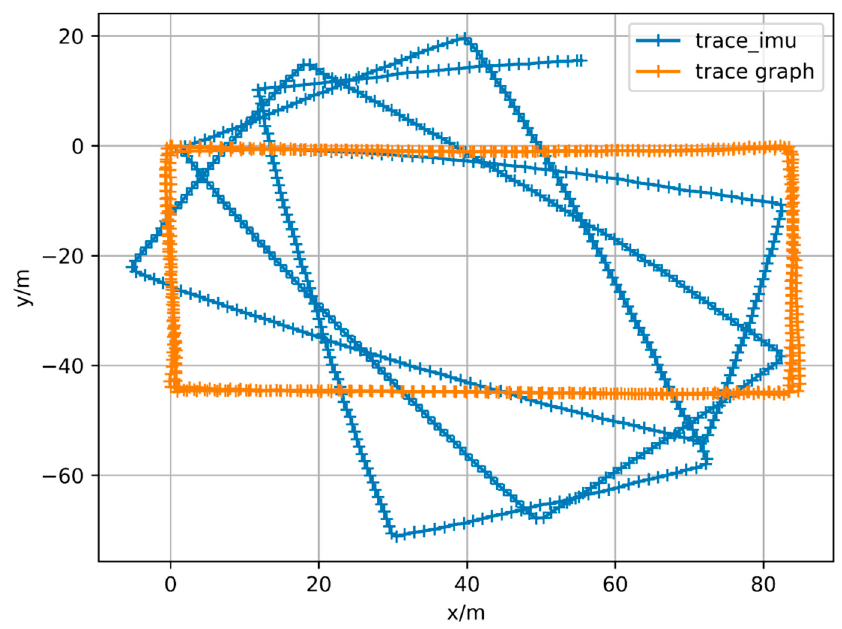
Figure 2. Reference Trajectory.